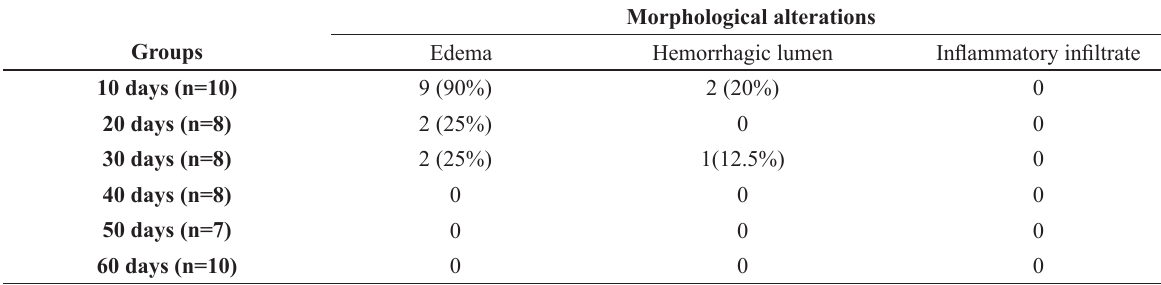
Classifications of morphological alterations found in the endometrium of bitches 10, 20, 30, 40, 50 and 60 days post ovulation. The presented values correspond to the numerical value (percentage) of uterine horns in which morphological alterations in histology staining with hematoxylin-eosin were found.